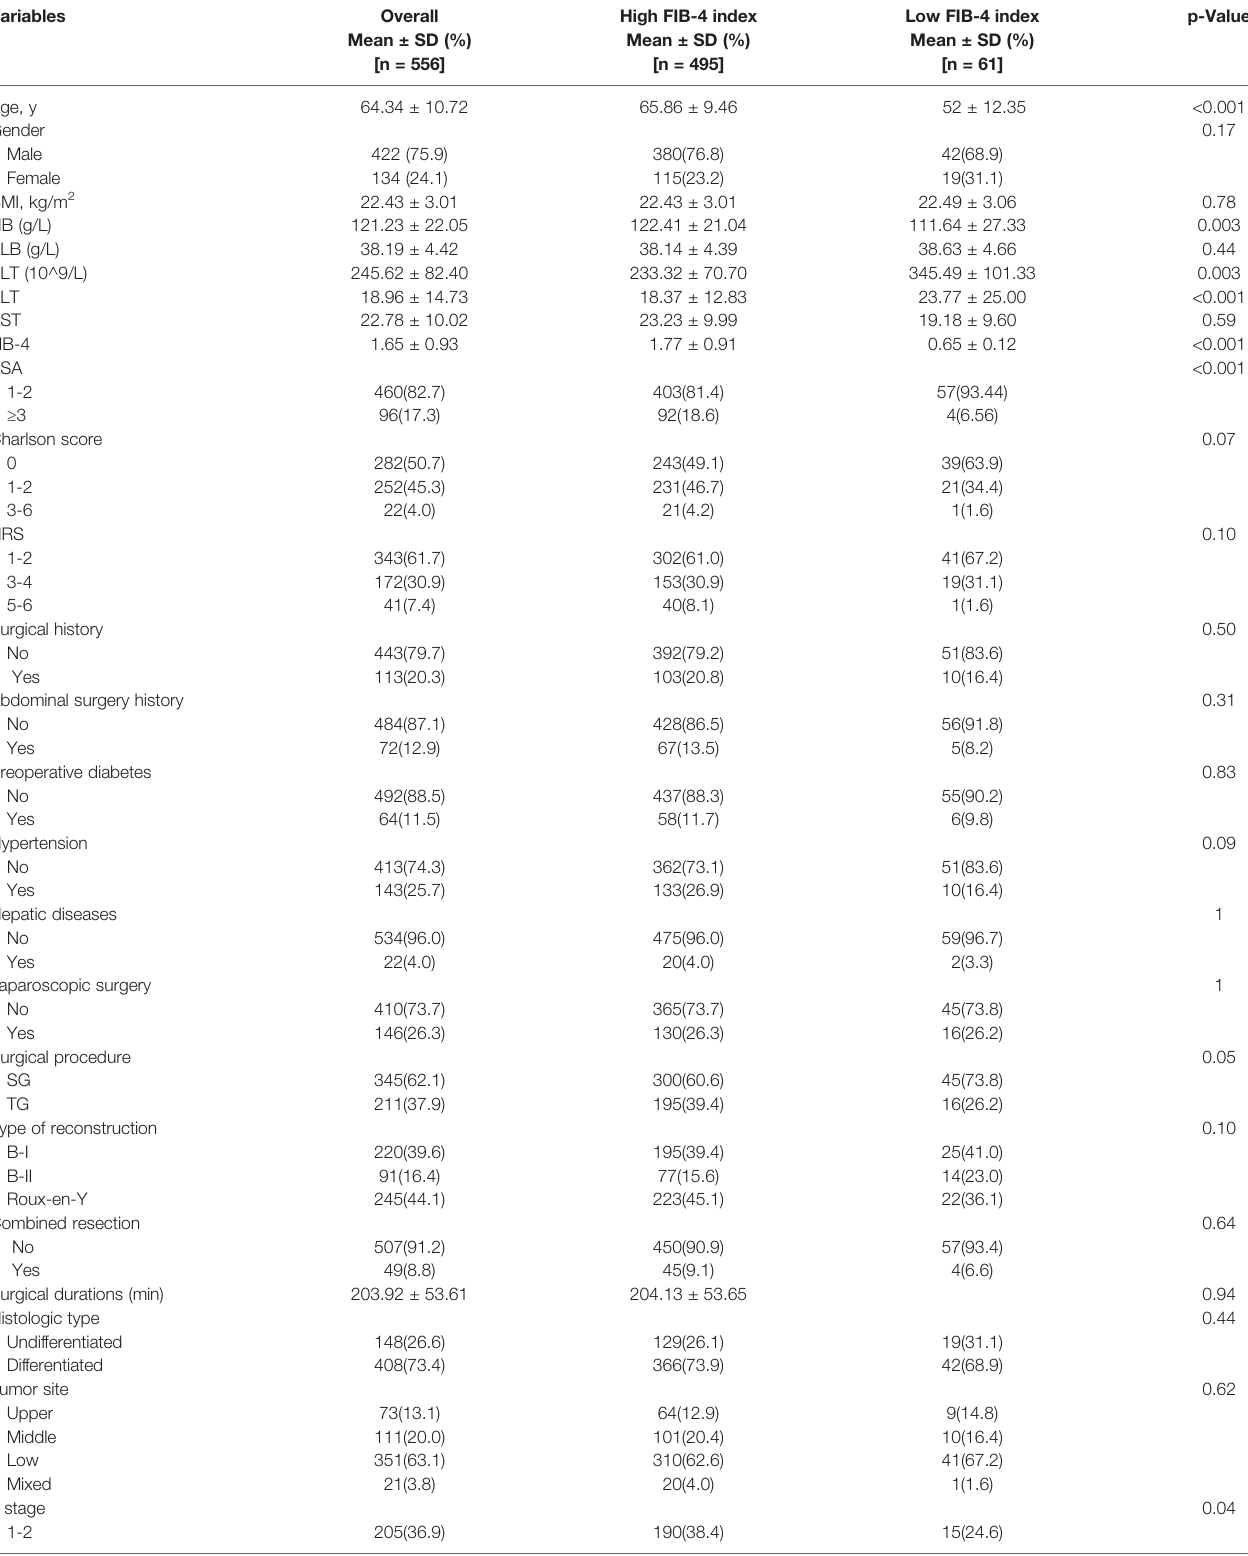
TABLE 1 | Preoperative backgrounds and comparison of backgrounds based on FIB-4